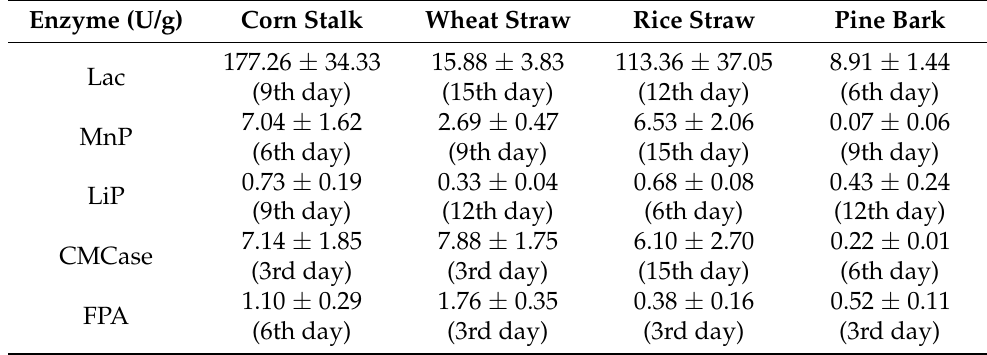
Table 3. Maximum enzyme activity of C. unicolor SP02 on different substrates.